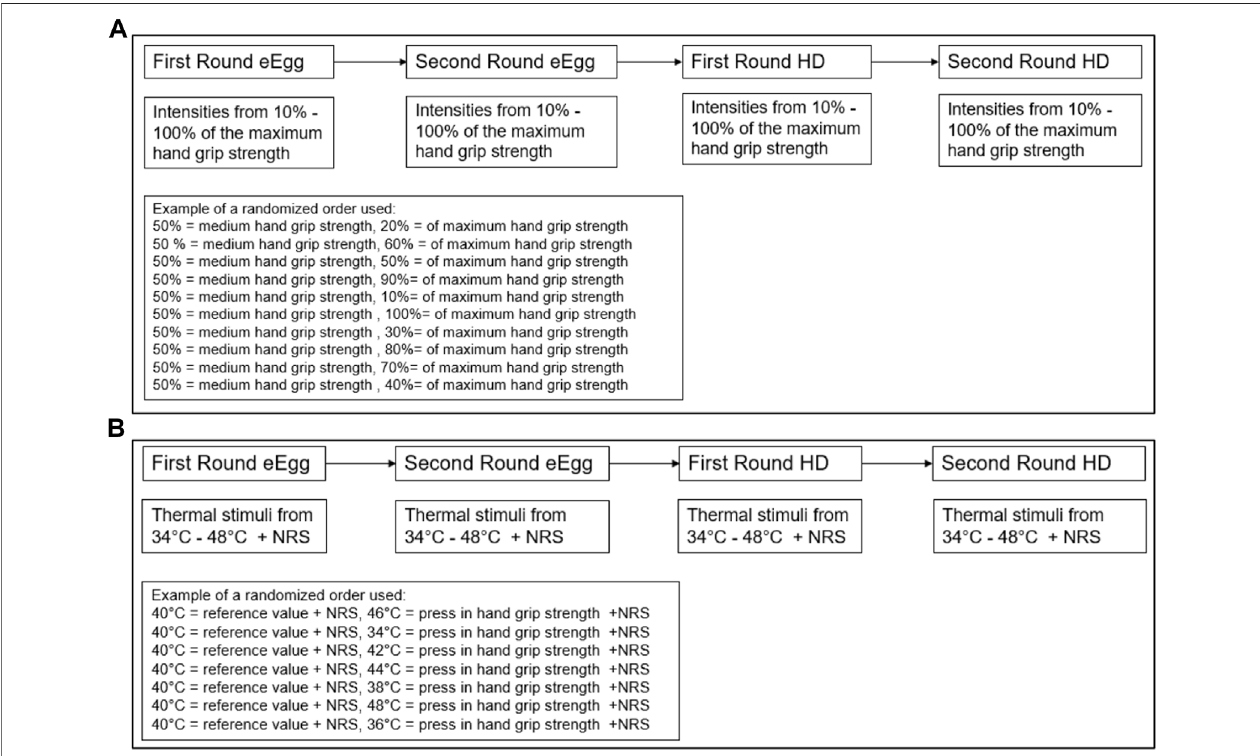
FIGURE 1 | Study design of the fi rst (A) and second (B) experimental tests. The order of the devices used (eEgg or hand dynamometer) was randomized. eEgg, electronic egg; HD, hand dynamometer.